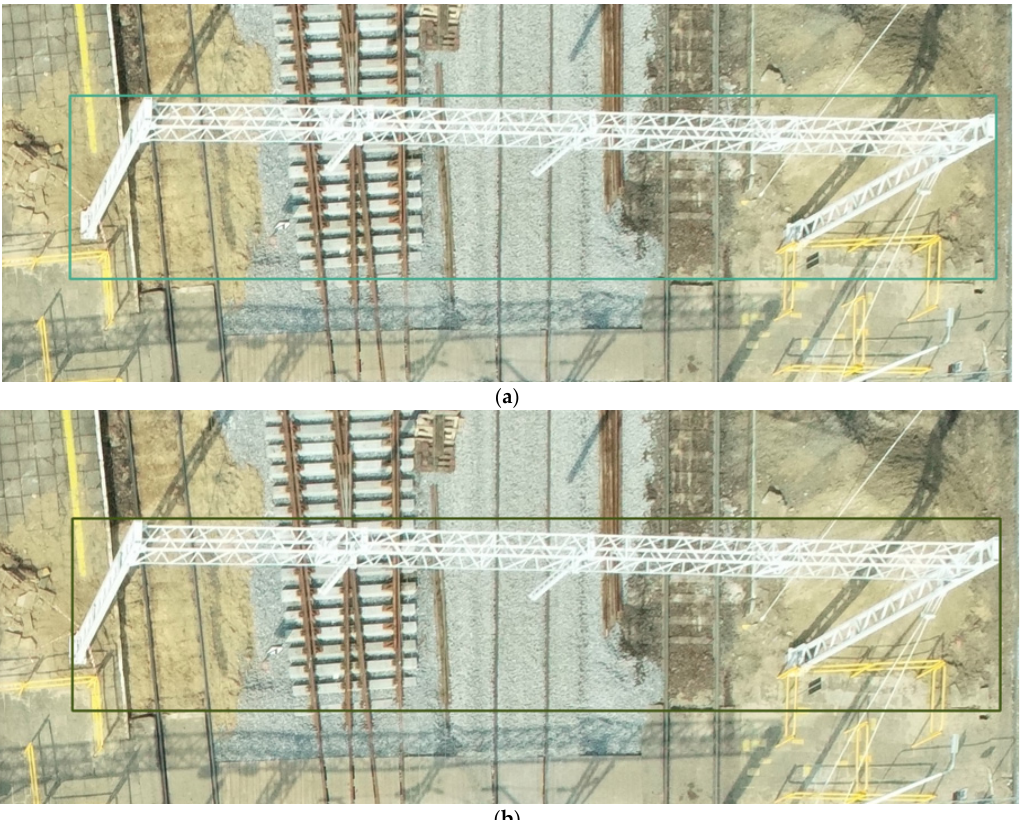
Figure 13. An example of a training dataset for gates with IoU = 0.90; ( a ) the bounding box generated from DIM point clouds; ( b ) ground-truth bounding box from TLS point cloud.